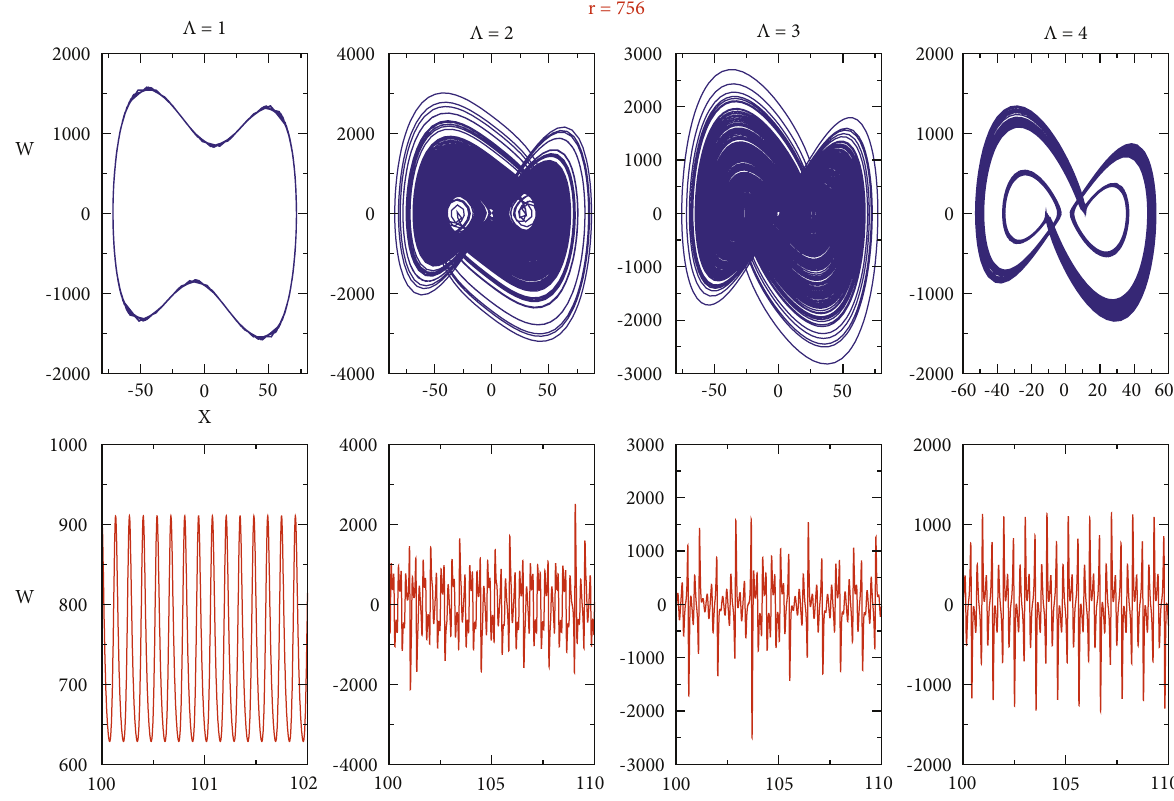
Figure 3: Phase portraits and time diagrams of the system for a fixed reduced Rayleigh number r � 765 and different values of Λ with the parameter values of Figure